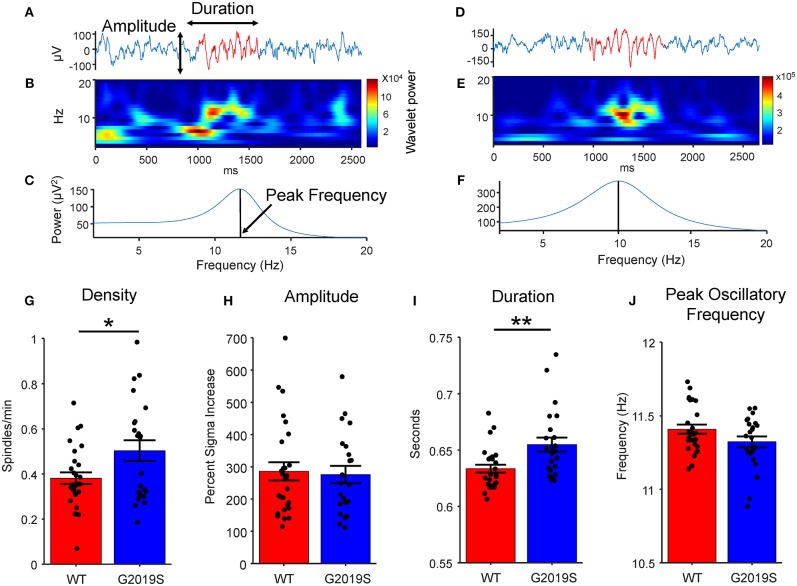
Spindle Identification and Properties. Two example traces with common average re-referenced signal show in blue and identified putative spindle shown in red, (A) one from a WT mouse and (D) one from a G2019S mouse. (B,E) Wavelet spectrogram of putative spindle events. (C,F) Spindle power spectral density using Matlab's pburg function. (G) G2019S animals had a greater sleep spindle density (spindles/minute of sleep) than did WT animals (t40 = −2.17, *p < 0.05). (H) There was no difference in spindle amplitude by genotype. (I) G2019S animals had significantly longer duration spindles than WT controls (t49 = −2.862, **p < 0.01 Wilcoxon Rank-Sum). (J) There was no significant difference between WT and G2019S peak spindle oscillatory frequency. Error bars indicate ± SEM.